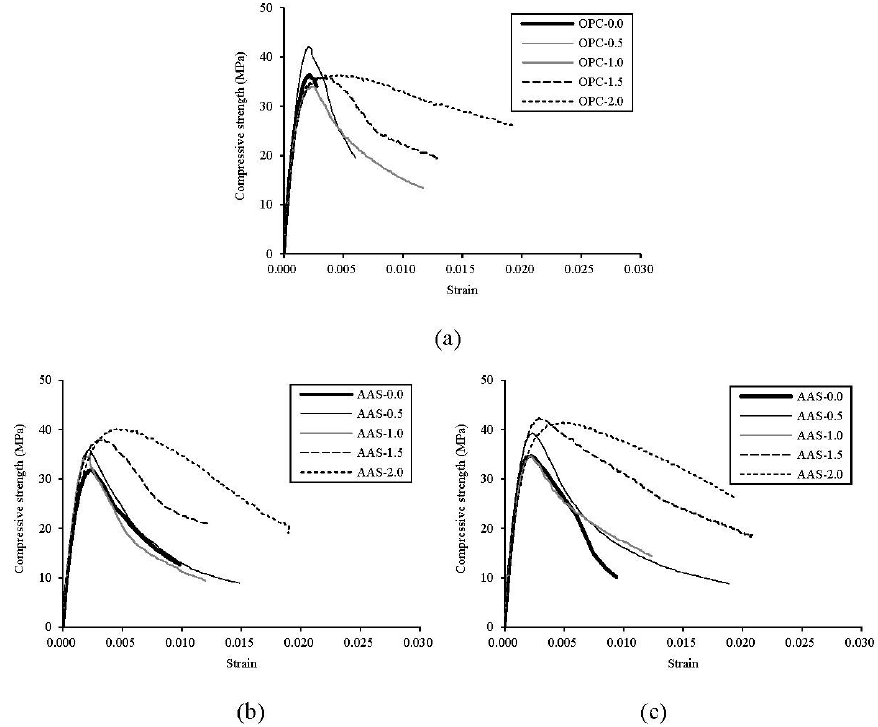
Figure 2. Stress-strain curves of test specimens at 28 days. ( a ) OPC-wet; ( b ) AAS-dry; ( c )